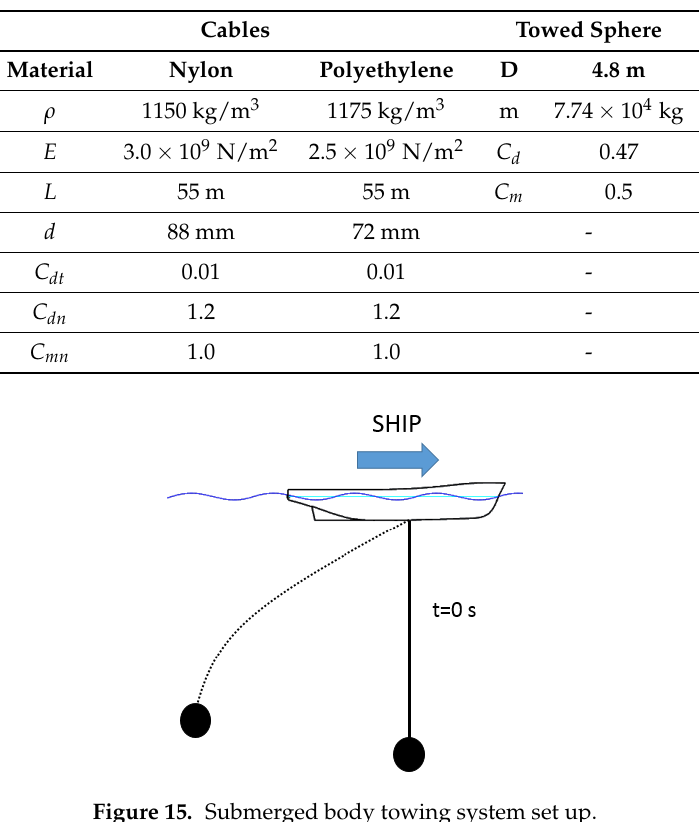
Table 1. Towing a submerged body data.